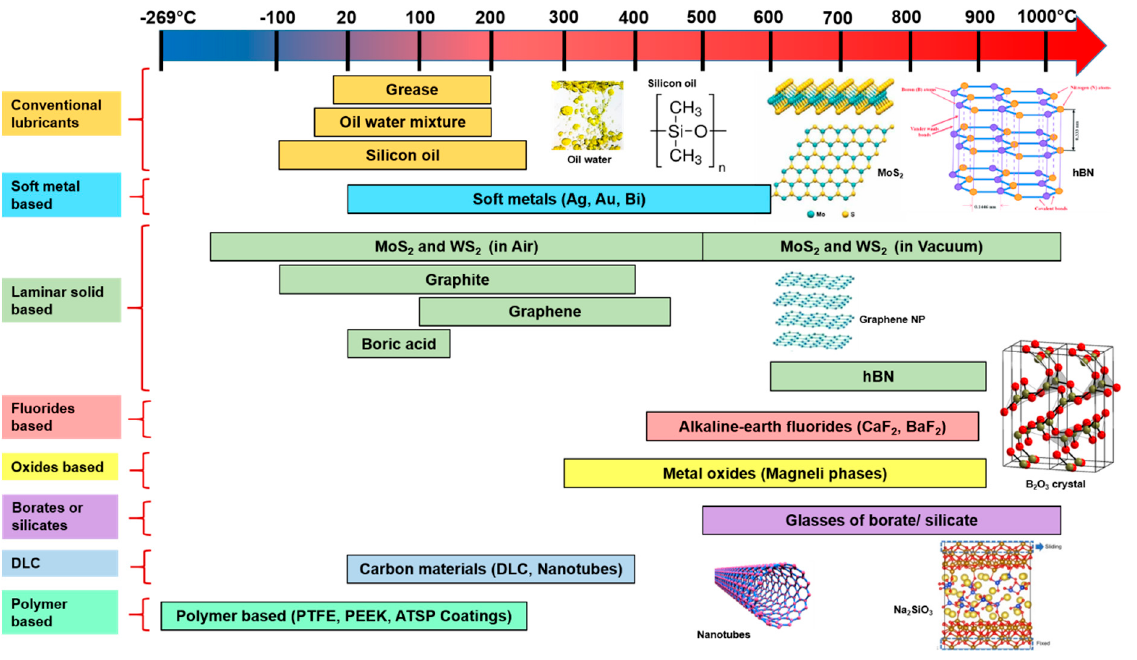
Figure 14. A graphical representation of effective temperature ranges for solid-lubricating materials (solid lubricants).